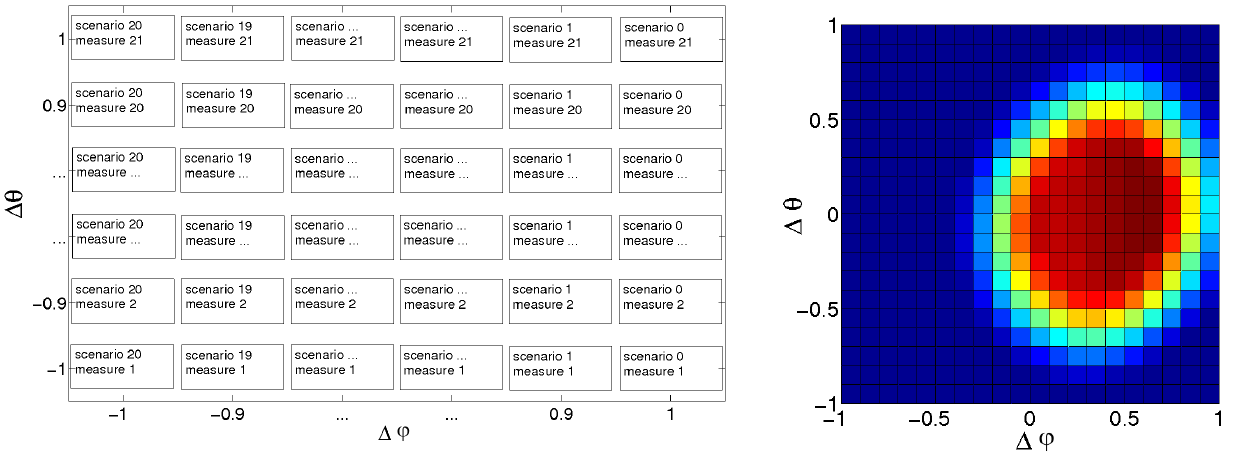
Fig. 3. Explanation of the matrix procedure in the subfigure on the left. On the right, a measurement taken at the Lille site on 22 Septem- ber 2010 at 12:47:07LT.